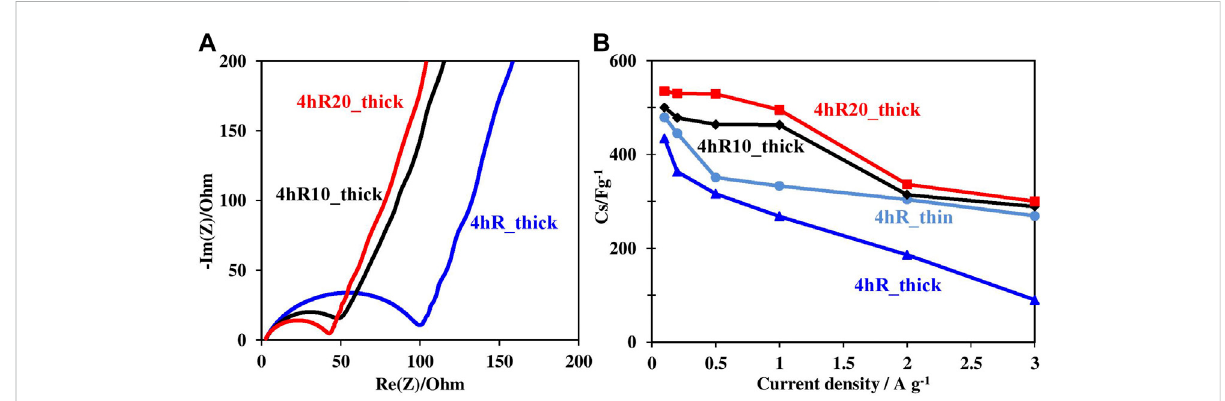
FIGURE 9 Electrochemical characterization of the electrodes based on 4hR TiO 2 with 20 wt% carbon black (4hR) and its composites with 10 wt% and 20 wt% CNTs (4hR10 and 4hR20) in LiPF 6 EC/PC/3DMC as the electrolyte: (A) Nyquist plot and (B) rate capability. The label “ thin ” after the sample